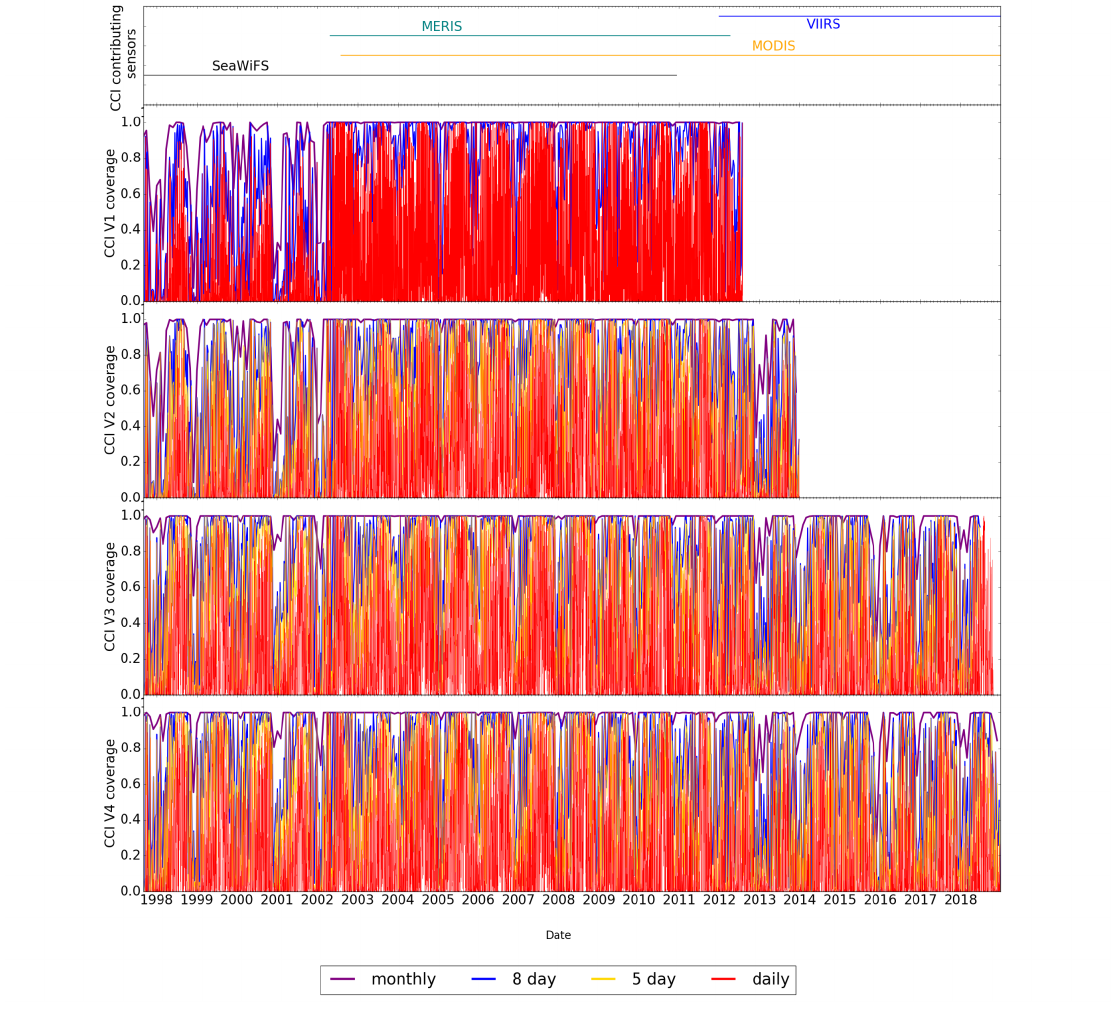
Figure 7. For the time series from September 1997 to December 2018, the number of pixels with valid chlorophyll data available from the various OC-CCI versions in a one-degree box centred on 41 ◦ N and 40 ◦ W, normalised to the number of pixels in the box, for 1-day, 5-day, 8-day, and 15-day composites: Five-day composites were not provided for v1. Note the improvement in coverage in SeaWiFS-only years in v3.1 and v4 compared with earlier versions because of incorporating SeaWiFS LAC